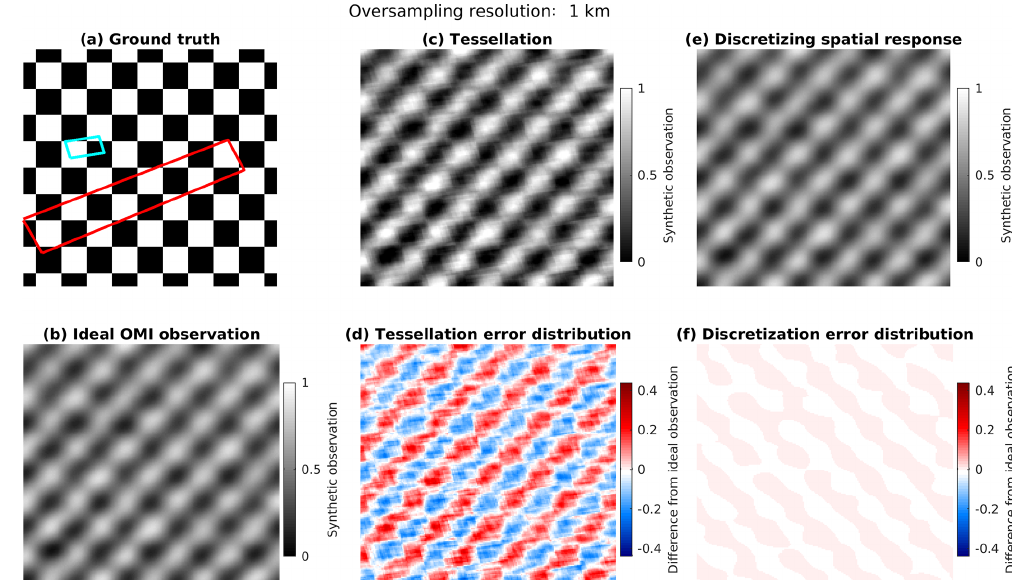
Figure 6. Oversampling a synthetic checkerboard pattern, shown in panel (a) , at a spatial scale smaller than the OMI pixels to a grid size of 1km. The pattern in panel (a) is the ground truth of the concentration distribution. The ideal OMI observation in panel (b) is generated using spatial response function defined in Fig. 5 at very fine grids and then co-added back to 1km. The pattern in panel (b) represents the ideal observation by OMI because no errors are introduced during the oversampling process. Panel (c) shows the result from the tessellation method (assuming S(i,j) is equal to the overlapping area between satellite pixel i and grid cell j ). Panel (d) shows the difference between tessellation and the ideal observation. The values in panel (d) are equal to the values in panel (c) minus the values in panel (b) . Panels (e, f) show the oversampling result by discretizing the spatial response function and its difference from the ideal observation. The values in panel (f) are equal to the values in panel (e) minus the values in panel (b)